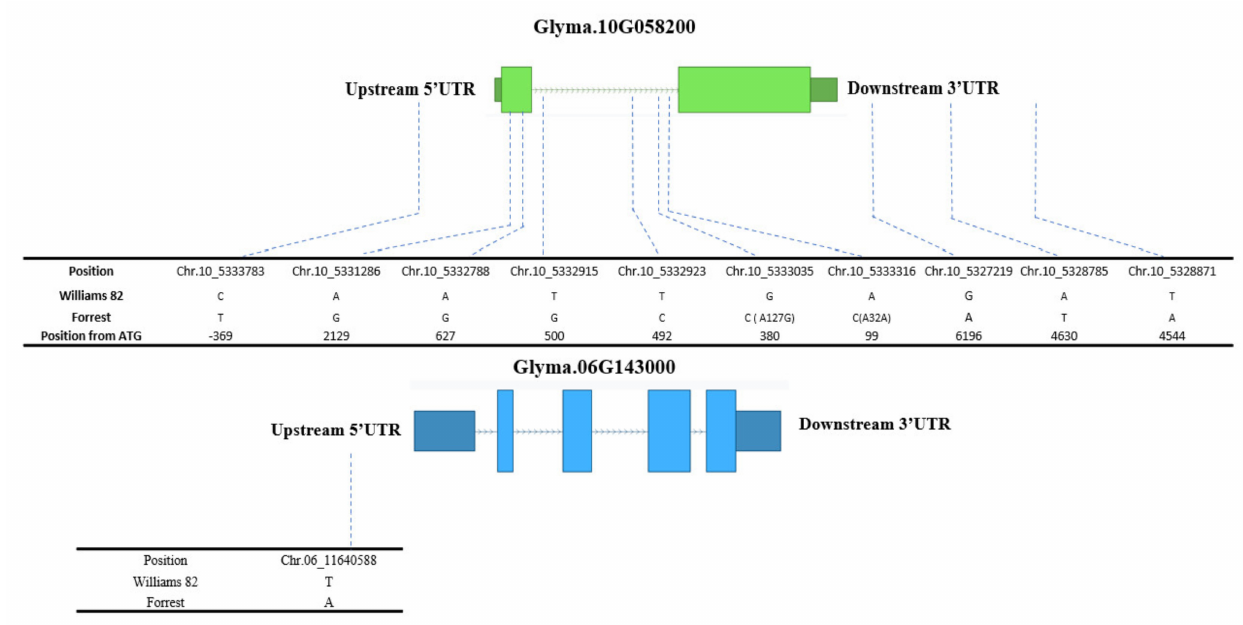
Figure 6. Positions of SNPs between Forrest and Williams 82 cultivars in Glyma.10G058200 and Glyma.06G143000